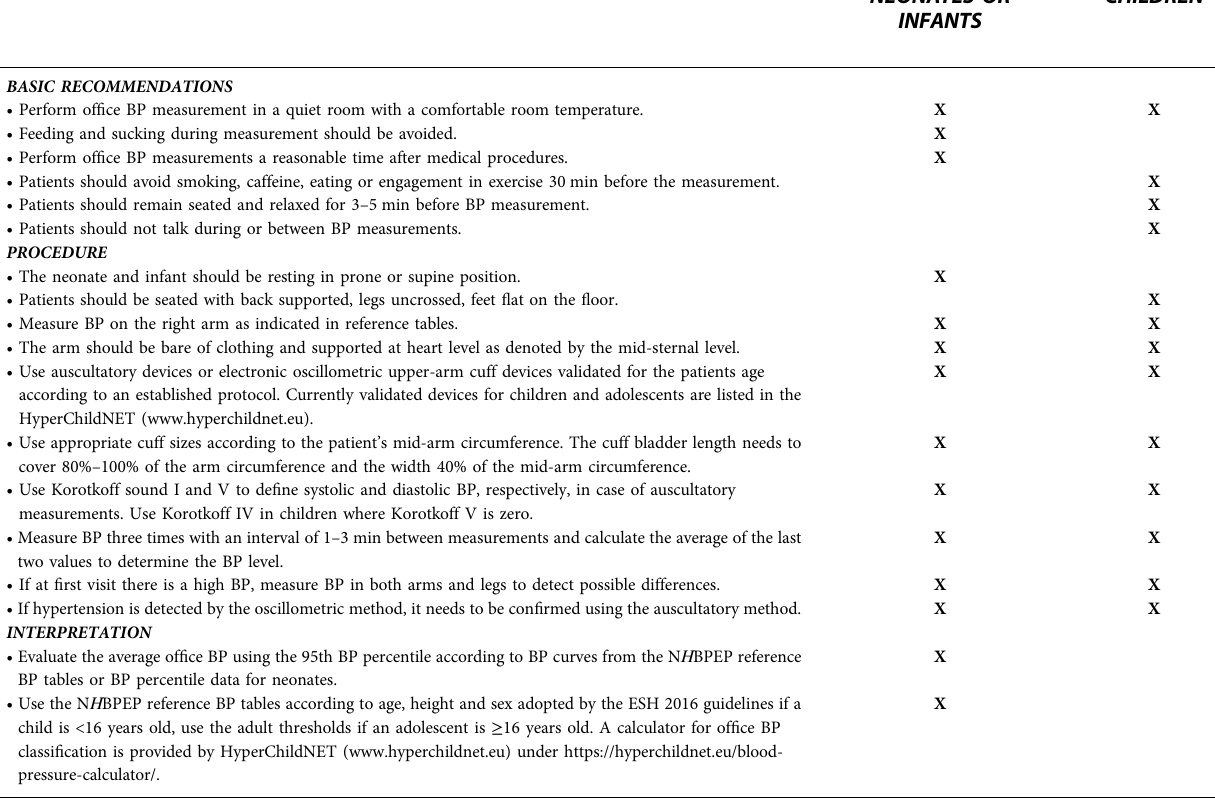
BOX 1 Methodology for of fi ce blood pressure